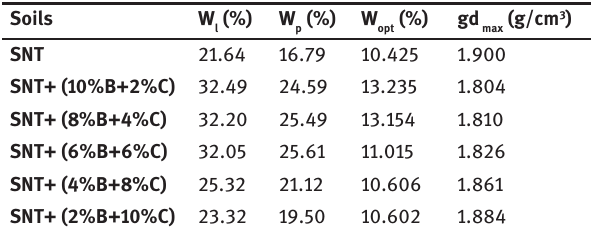
Table 4: Geotechnical characteristics of soils.